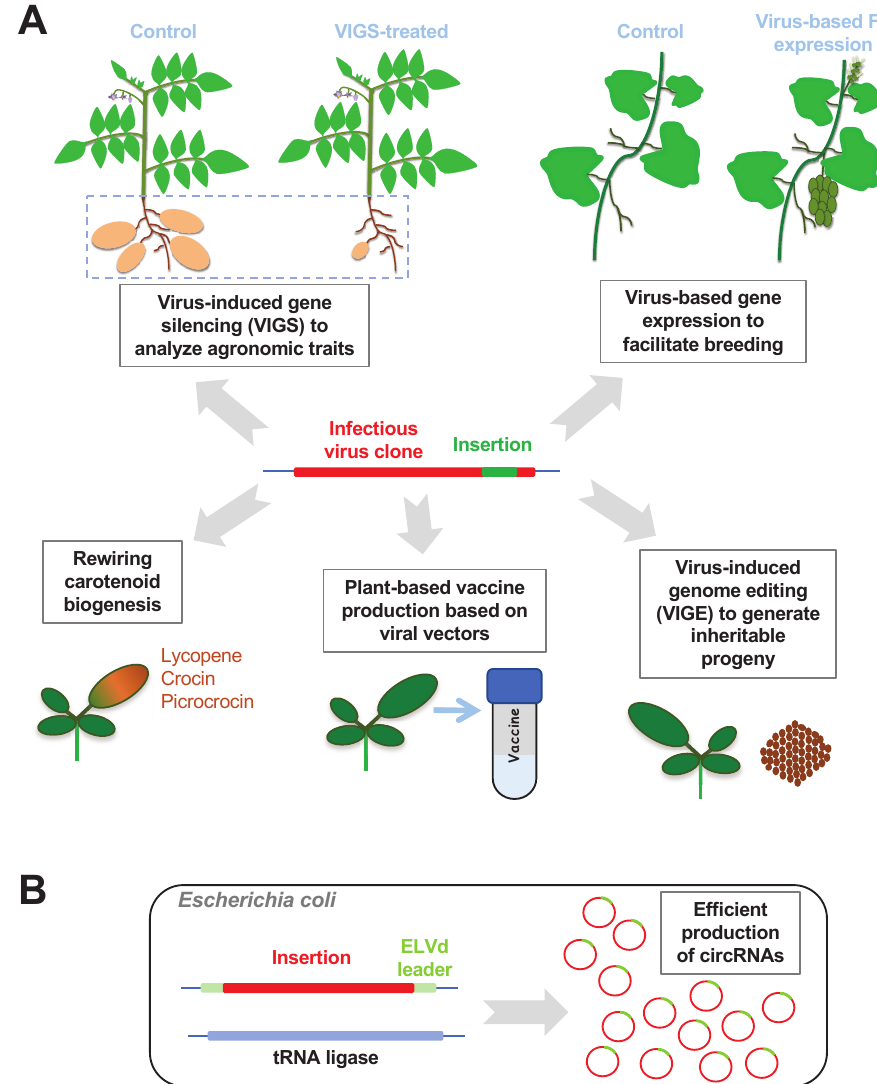
Figure 1. Plant virus / viroid-based technology. ( A ) Application of plant virus vectors in agriculture and production of carotenoids and vaccines. Virus-induced gene silencing (VIGS) has been used to characterize genes controlling important crop traits, exemplified by tuber formation (highlighted by blue dashed lines) in potato plants. Virus-based gene expression of FT (Flowering Locus T) can induce early flowering in grapevines, shortening the time for molecular breeding. VIGE in plants can shorten the time in generating stable transgenic progeny. Viral-based expression platform can be used for the production of vaccines and health-promoting carotenoids. ( B ) Viroid-based platform for circular RNA production. ELVd, eggplant latent viroid. circRNA, circular